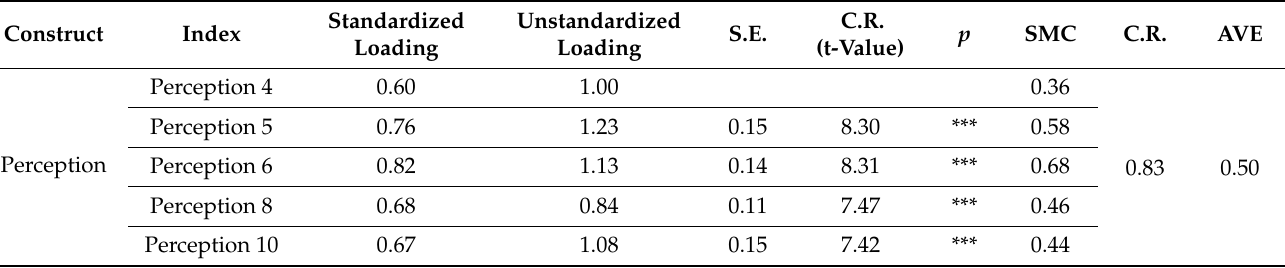
Table 3. Perception–verification analysis.